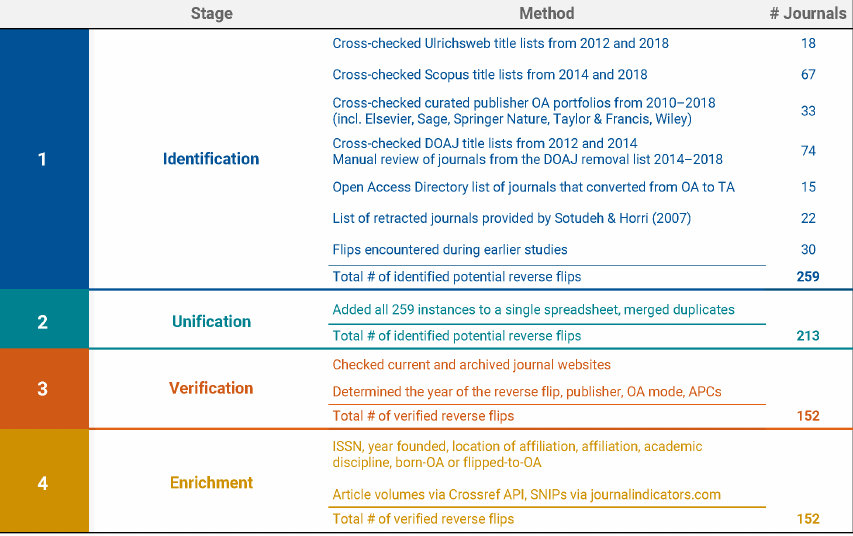
Figure 1. The data collection process in four stages: (1) Identification, (2) Unification, (3) Verification, and (4) Enrichment.